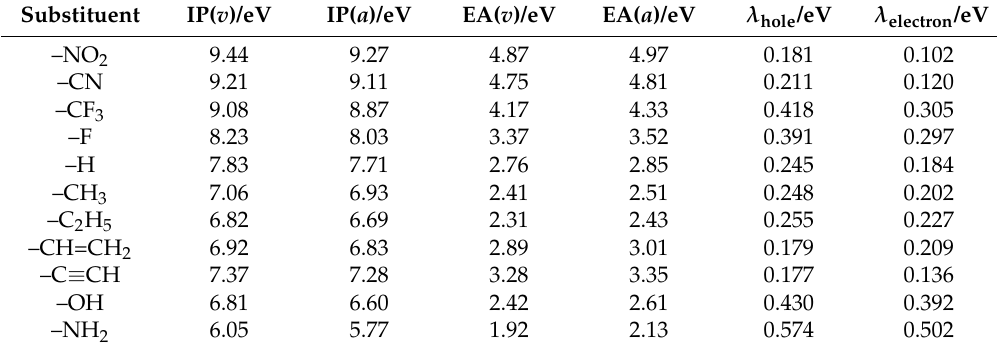
Table 2. The ionization potentials, electron affinities and reorganization energies of Ni(S 2 C 2 R 2 ) 2 . (R = –NO 2 , –CN, –CF 3 , –F, –H, –CH 3 , –C 2 H 5 , –CH=CH 2 , –C ≡ CH, –OH, –NH 2